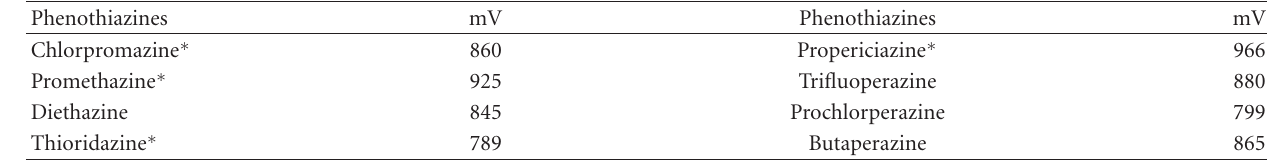
Scheme 1: The oxidation of PM by means of FeCl 3 . Table 3: Reduction potentials of PT.